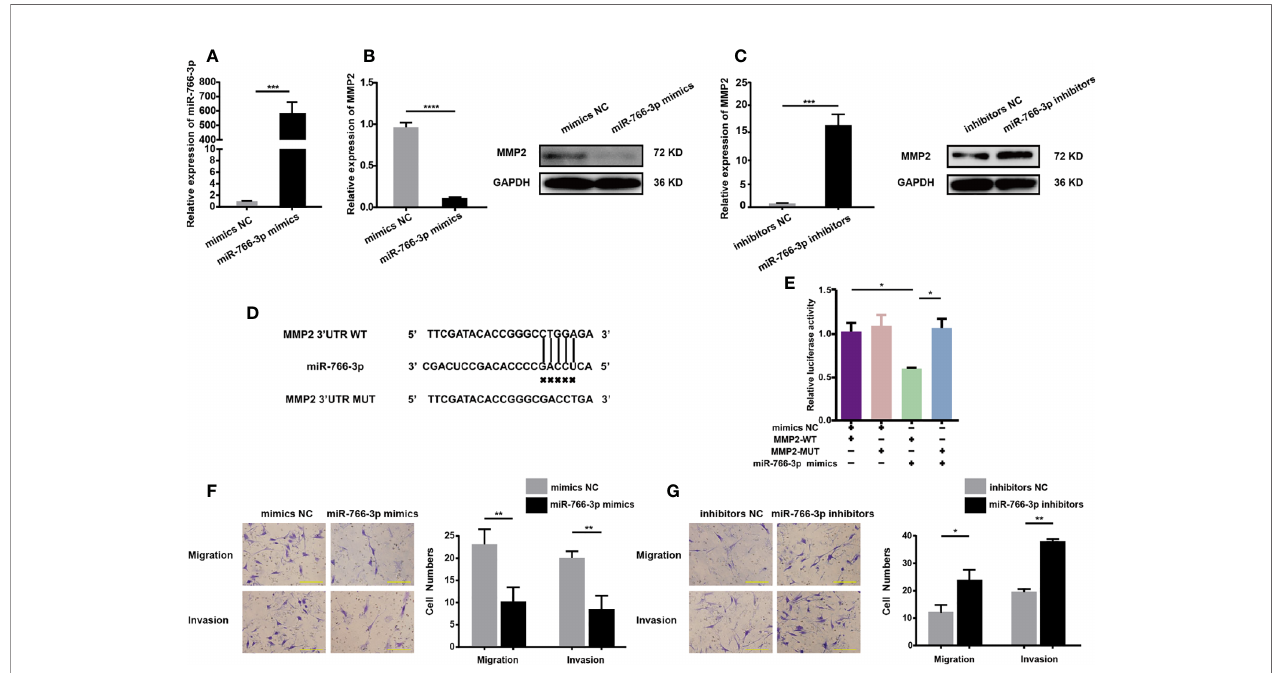
FIGURE 5 | MiR-766-3p inhibits RA-FLS migration and invasion. (A) RA-FLSs were transfected with the miR-766-3p mimics or the negative control (NC) at a fi nal concentration of 50 nM. The expression level of miR-766-3p was determined using qRT-PCR. (B) QRT-PCR and Western blotting determination of MMP2 expression in RA-FLSs. RA-FLSs were transfected with miR-766-3p mimics. (C) QRT-PCR and Western blotting detection of MMP2 expression in RA-FLSs. RA- FLSs were transfected with miR-766-3p inhibitors. (D) Wild-type (WT) or mutant (MUT) miR-766-3p target sequences in the MMP2 3 ′ UTR. (E) The miR-766-3p mimics reduced the luciferase activities of WT but not MUT MMP2 reporter gene, as detected using dual-luciferase reporter assays. (F) Assays of RA-FLSs migration and invasion in cells transfected with miR-766-3p mimics. Scale bar, 500 µm. (G) Assays of RA-FLSs migration and invasion in cells transfected with miR-766-3p inhibitors. Scale bar, 500 µm. Data are shown as mean ± SD. *indicates p < 0.05, **indicates p < 0.01, ***indicates p < 0.001, and ****indicates p <